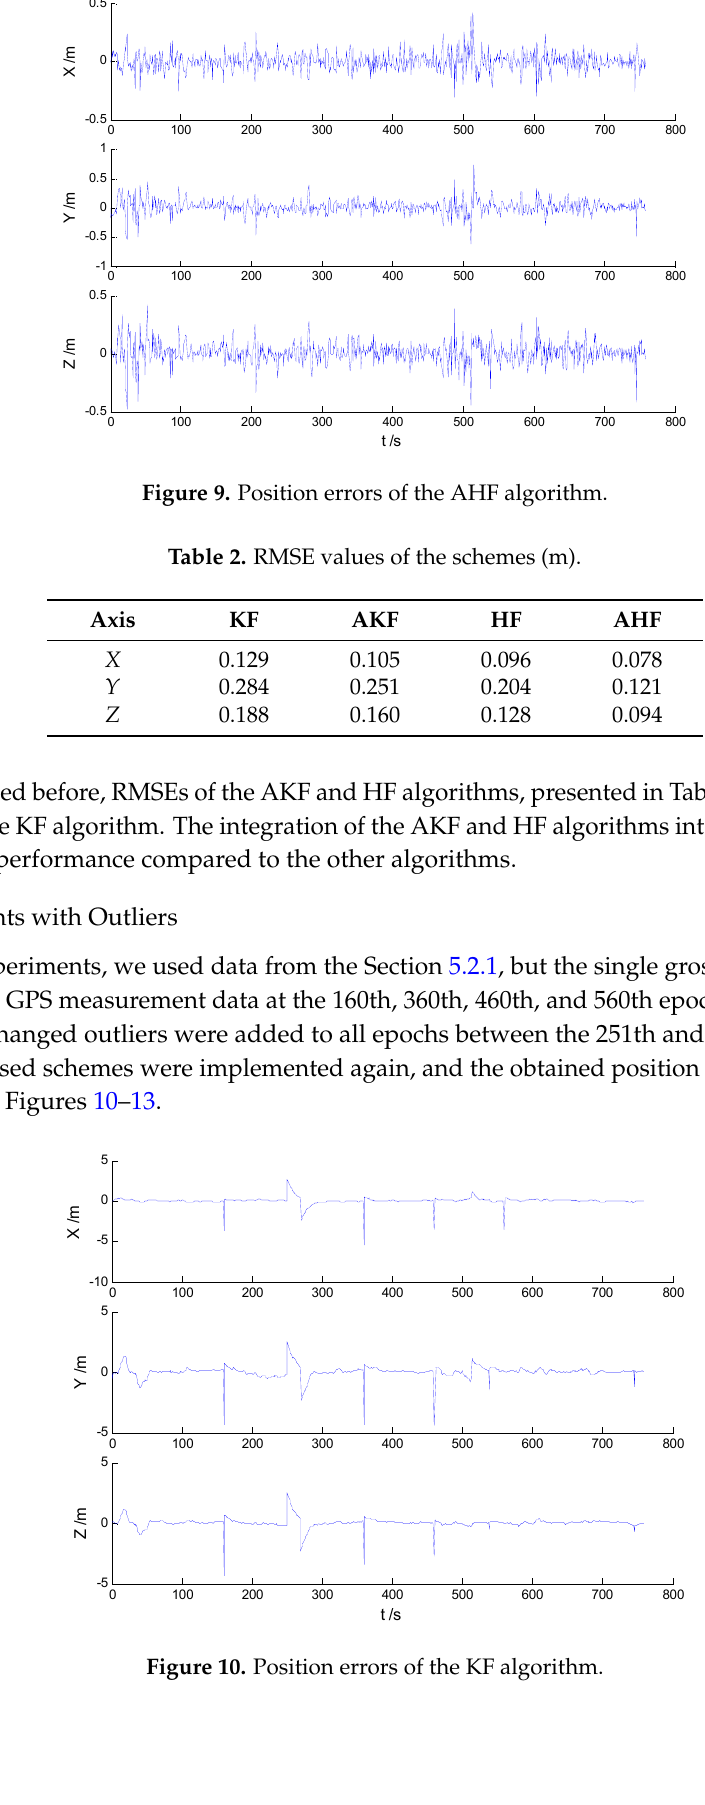
Figure 8. Position errors of the HF algorithm.